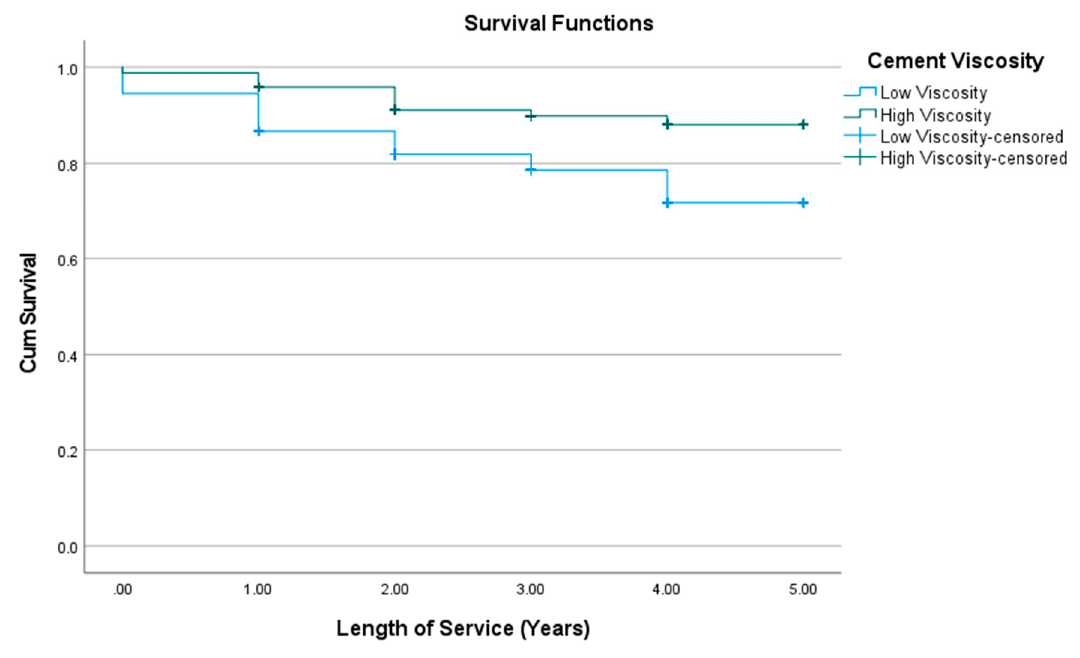
Figure 6. Kaplan-Meier survival curve of composite restorations stratified by cement viscosity, Palacky University Hospital, 2014–2018 ( n = 469). CumSurvival = cumulative survival.